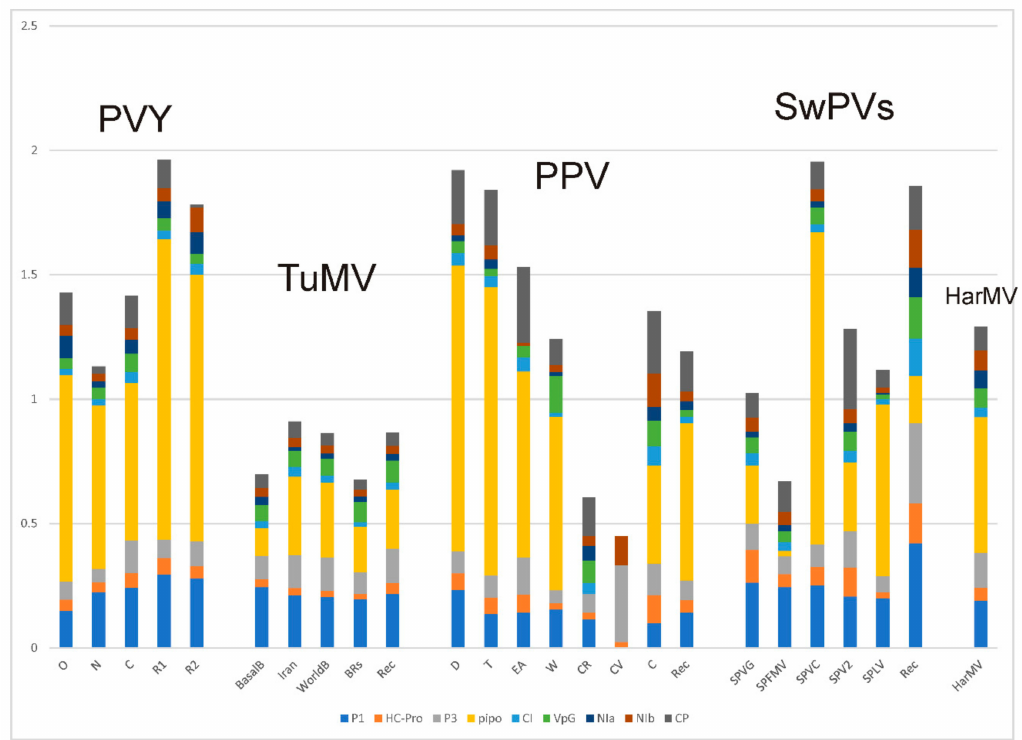
Figure 7. A stacked column chart of the ω (dN / dS) values of the genes of populations of di ff erent potyvirus phylogroups / groups / strains. The N-terminal protein (P1) is at the base of each column. Comparisons of the popgen results for the five viruses are instructive. There are five major phylogroups in the world PVY population (Figure 6), three of them (O, C, and N) are mostly n-rec, and two populations, R1 and R2, are based on single and double OxN recombinants.